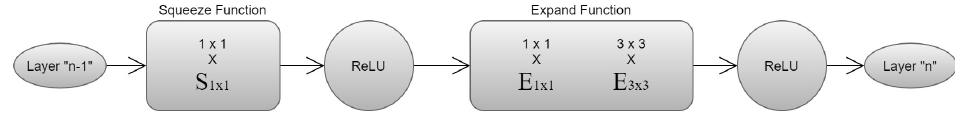
Figure 14. SqueezeNet’s fire block.